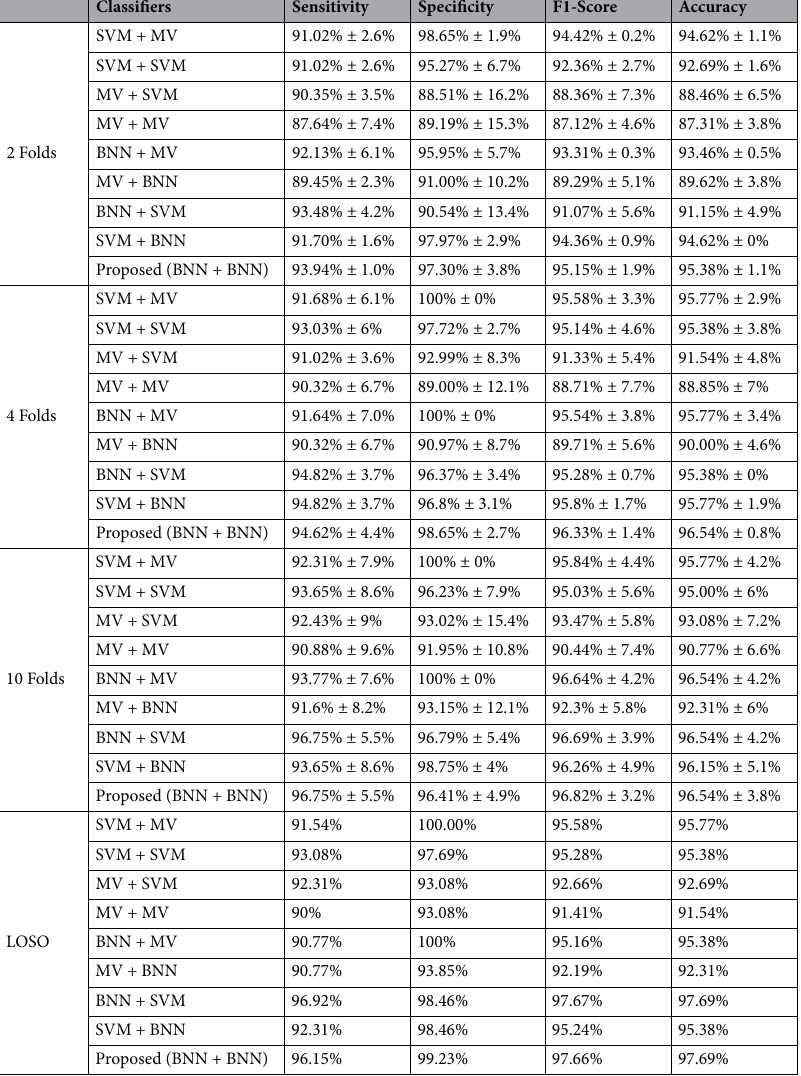
Table 5. Classification accuracy of the proposed BNN-based fusion system compared with other different fusion approaches. The left and the right sides of the “ + ” in the second column indicate the fusion approach for four markers at each layer and the fusion approach of the twelve layers to make the final decision, respectively. Note that: SVM, MV, BNN, and LOSO stand for support vector machine, majority voting, backpropagation neural network, and leave-one-subject-out, respectively.